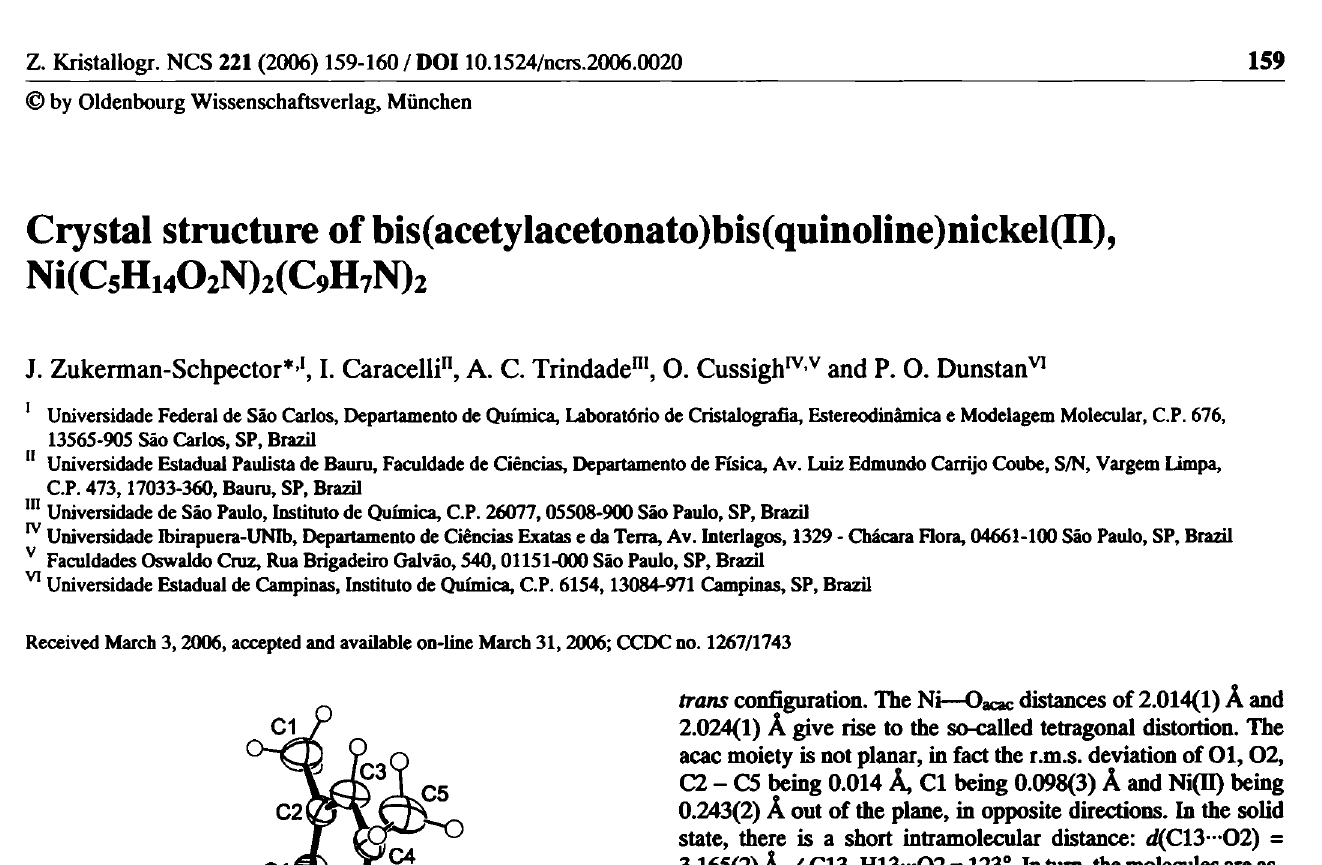
Table I. Data collection and handling.